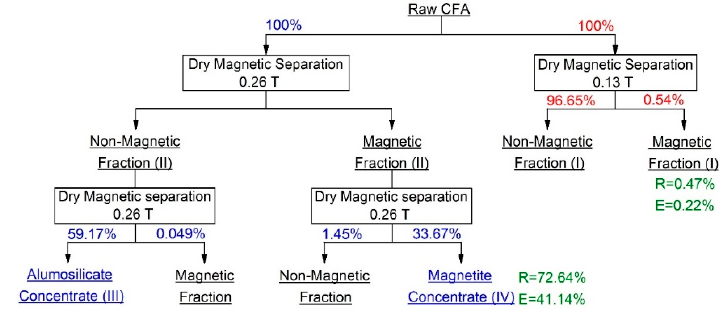
Figure 3. Flowchart of the dry magnetic separation of the Omsk CFA for the magnetite and alumosilicate concentrates obtained (in all tests, losses of CFA were from 1.4 to 3.3%). Table 2. Chemical composition (wt %) of the fraction after dry magnetic separation of the raw CFA *. Name of Fraction